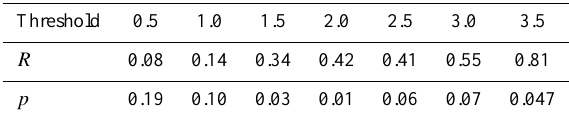
Table 4. The Pearson correlation index between SM obtained vary- ing the threshold from 0.5 up to 3.5 along with the significance of the correlation.